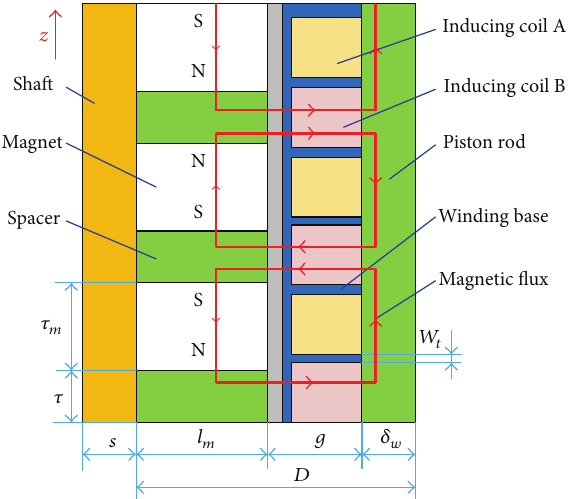
Figure 2: Magnetic circuit of the linear power generator.